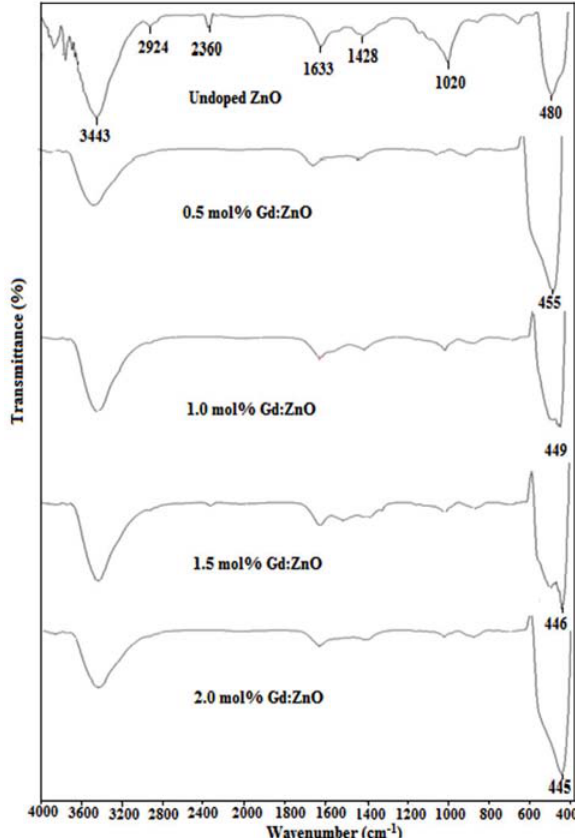
Figure 2b. FT-IR spectra of undoped and Gd doped ZnO nanopar- ticles synthesized using